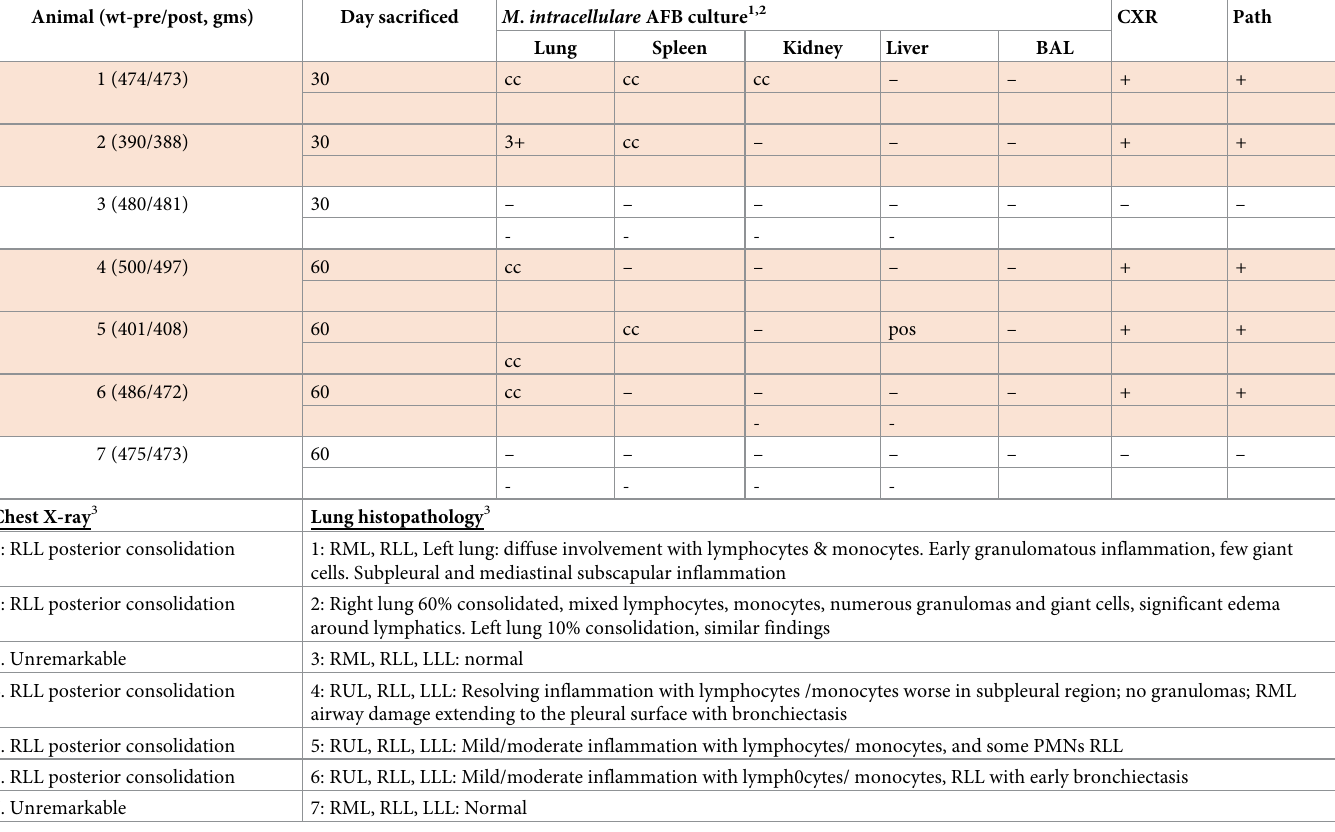
Table 1. Summary of microbiologic, radiographic and pathologic findings from each animal. Animal (wt-pre/post,